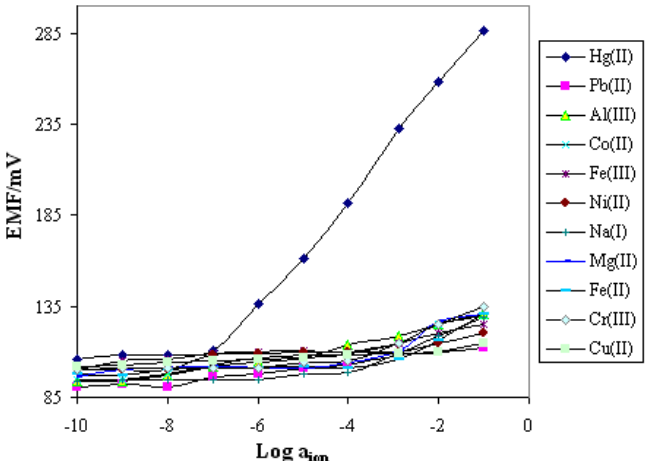
Fig. 3. The potential responses of various ion-selective electrode based on the 3-((3-mercaptophenyl) aminomethyl)benzene-1,2-diol.